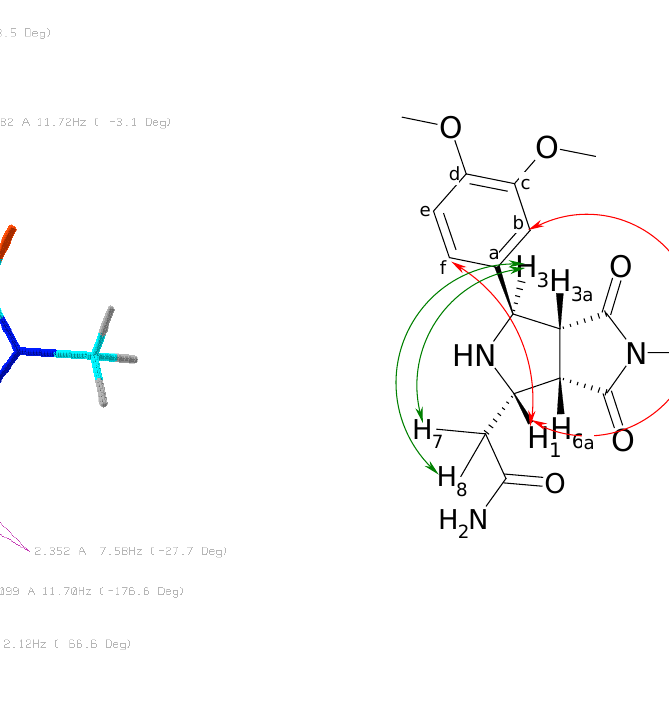
Figure 3. Molecular modeling structure and NOE interactions of (1S*, 3R*, 3aR*, 6aS*)-2-[3-(3,4-dimethoxyphenyl)-5-methyl-4,6-dioxooctahydropyrrolo[3,4- c]pyrrol-1-yl]acetamide ( 6a)